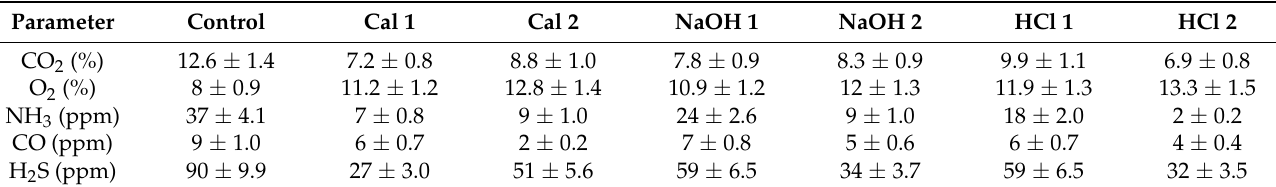
Table 6. Results of experiment 1.